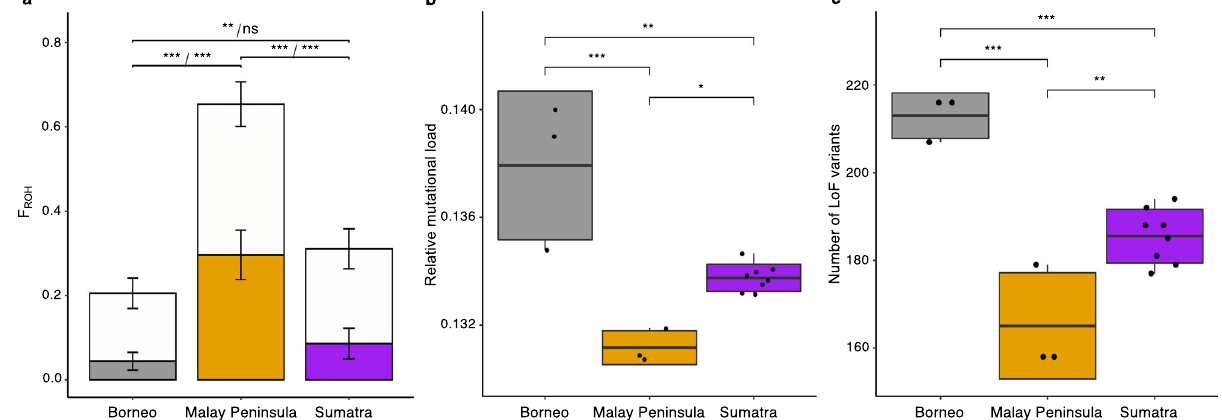
Fig. 3 Inbreeding, relative mutational load and number of loss-of-function (LoF) variants in three modern populations of Sumatran rhinoceros ( Dicerorhinus sumatrensis ). a Inbreeding estimated as the average proportion of the genome in runs of homozygosity (F ROH ). Open bars show total proportion of the genome in ROH ≥ 100 kb and solid bars show proportions in ROH of length ≥ 2 Mb. Bars extending from the mean values represent the standard deviation (two-sided pairwise t -test, F ROH ≥ 100 kb: p Borneo-MalayP = 4.2e − 07, p Borneo-Sumatra = 0.0066, p MalayP-Sumatra = 6.4e − 07, F ROH ≥ 2 Mb: p Borneo-MalayP = 2.2e − 05, p Borneo-Sumatra = 0.15, p MalayP-Sumatra = 2.2e − 05). b Mutational load estimated with GERP scores. Individual relative mutational load was measured as the sum of all derived alleles multiplied by their conservation-score over the total number of derived alleles (see ‘ Methods ’ ). Only derived alleles above conservation-score of 1 (i.e., non-neutral) were included (two-sided pairwise t -test, p Borneo-MalayP = 0.00013, p Borneo-Sumatra = 0.001, p MalayP-Sumatra = 0.012. c Number of LoF variants using an annotation of 33,026 gene predictions for a white rhinoceros genome assembly (see ‘ Methods ’ ) (two-sided pairwise t -test, p Borneo-MalayP = 2.2e − 05, p Borneo-Sumatra = 0.0004, p MalayP-Sumatra = 0.0019). Middle thick lines within boxplots and bounds of boxes represent mean and standard deviation, respectively. Vertical lines represent minima and maxima. n = 14, *** p < 0.001, ** p < 0.01, * p < 0.05, ns = non-signi fi cant, p -values were not adjusted for multiple